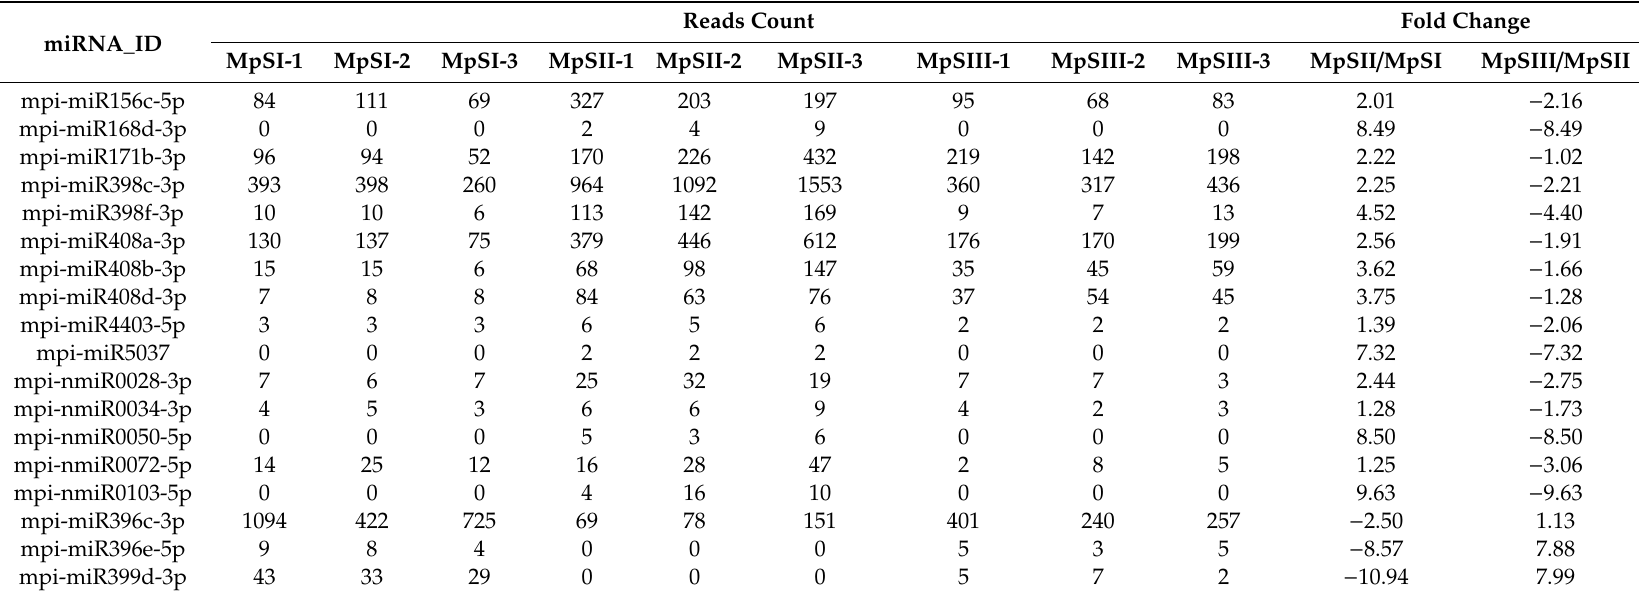
Table 3. Pongamia miRNAs with the opposite tendencies of expression changes in two comparisons between developmental phases.